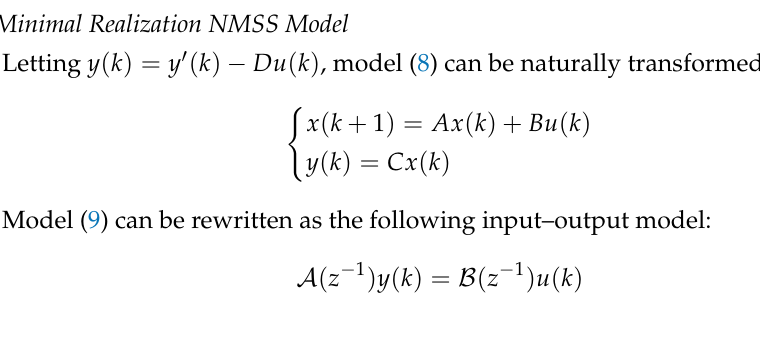
Figure 6. Prediction value of CVs and their real